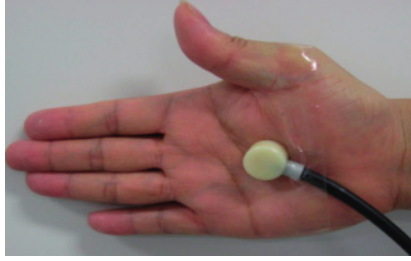
Figure 3. Palm with attached